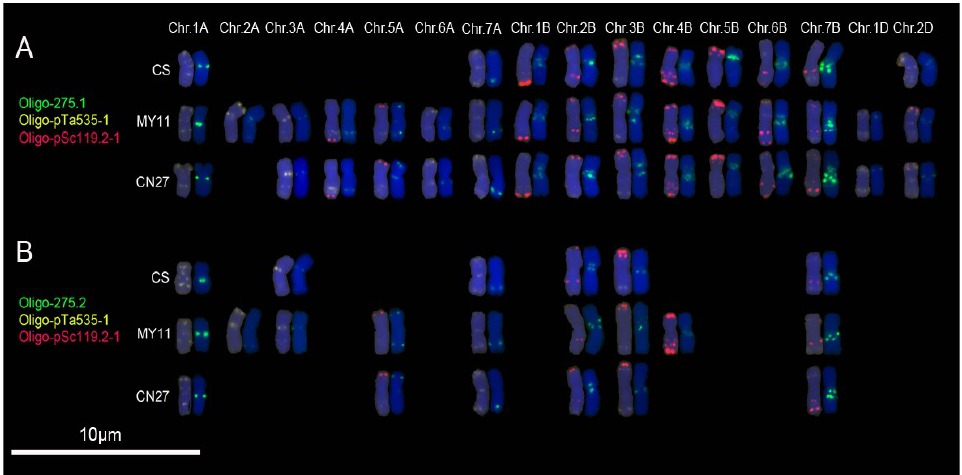
Figure 3. Oligo-275.1 ( green ) and Oligo-275.2 ( green ) combined with Oligo-pTa535-1 ( yellow ) and Oligo-pSc119.2-1 ( red ) were used as probes for ND-FISH analysis of root tip metaphase chromosomes of wheat varieties CS, MY11 and CN27: ( A ) Oligo-275.1 hybridization patterns; and ( B ) Oligo-275.2 hybridization patterns. Only the chromosomes with strong or clear signals of Oligo-275.1 or Oligo-275.2 were cut and pasted. Chr.: chromosome. Chromosomes were counterstained with DAPI ( blue